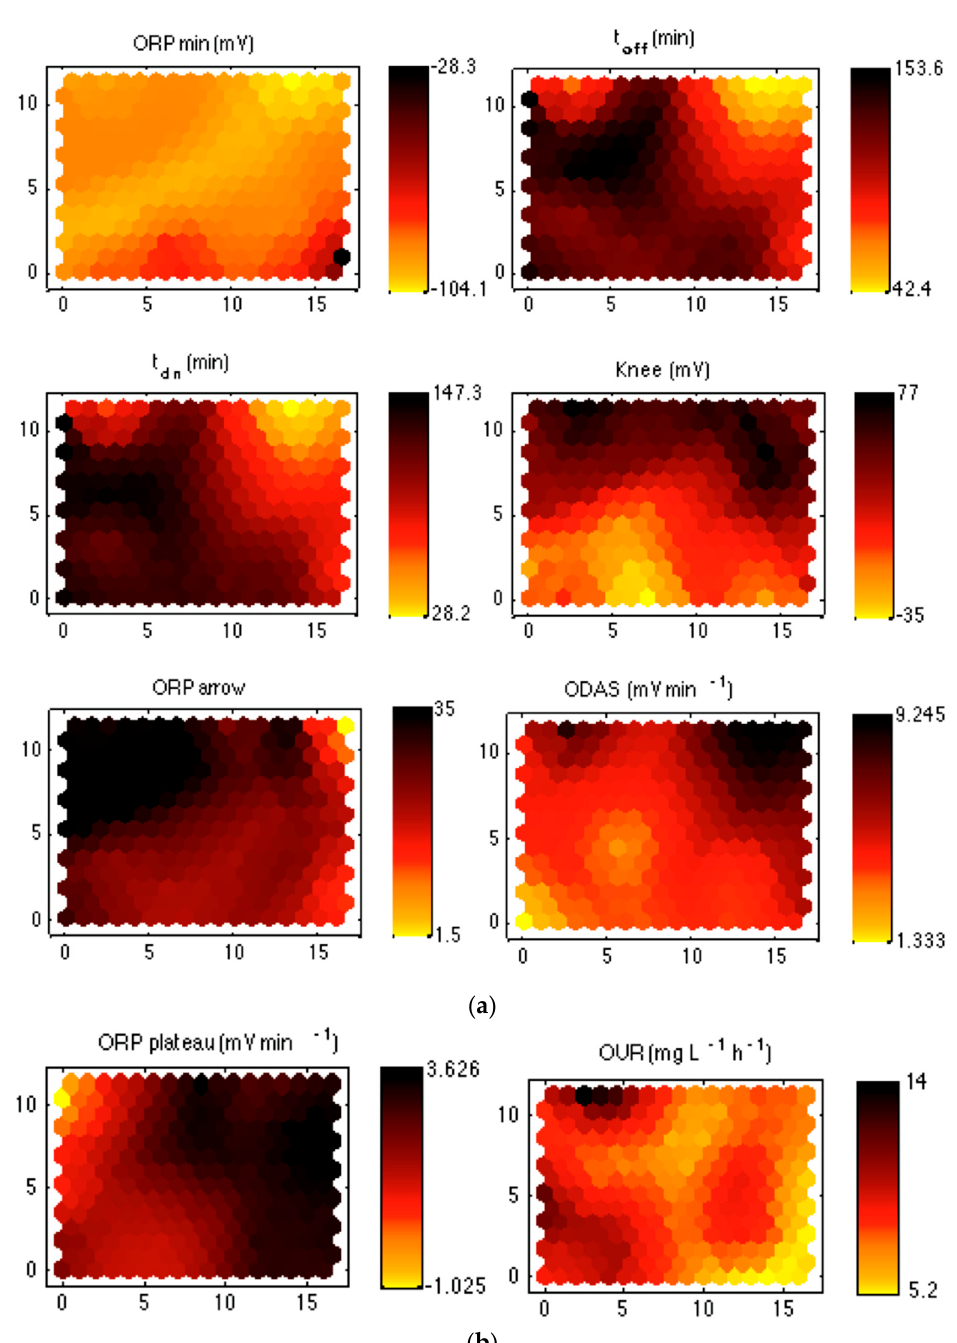
Figure 5. ( a ) The 6 component maps corresponding to the parameters associated with the non-aeration-reduction process; ( b ) The 2 maps corresponding to the parameters associated with the oxidation-reduction transition.